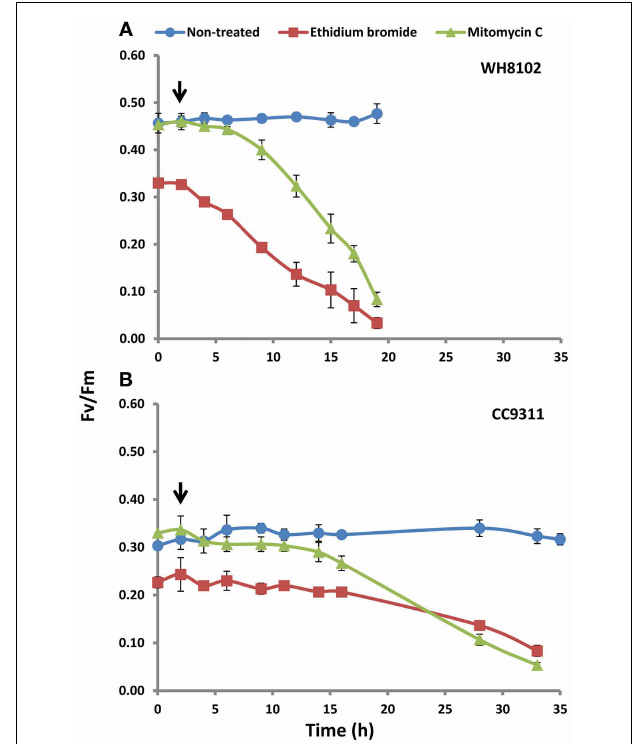
FIGURE A2 | Photosynthetic efficiency of photosystem II in (A) WH8102 and (B) CC9311 on treatment with EB and MC, and with no treatment as determined using PAM fluorometry. The axes represent Fv/Fm (ratio of variable fluorescence and maximum fluorescence) against treatment time in hours. The experiment was carried out in triplicate and the mean plotted. The error bars represent standard deviation. The arrow represents the point of 2h exposure at which RNA was isolated for microarray